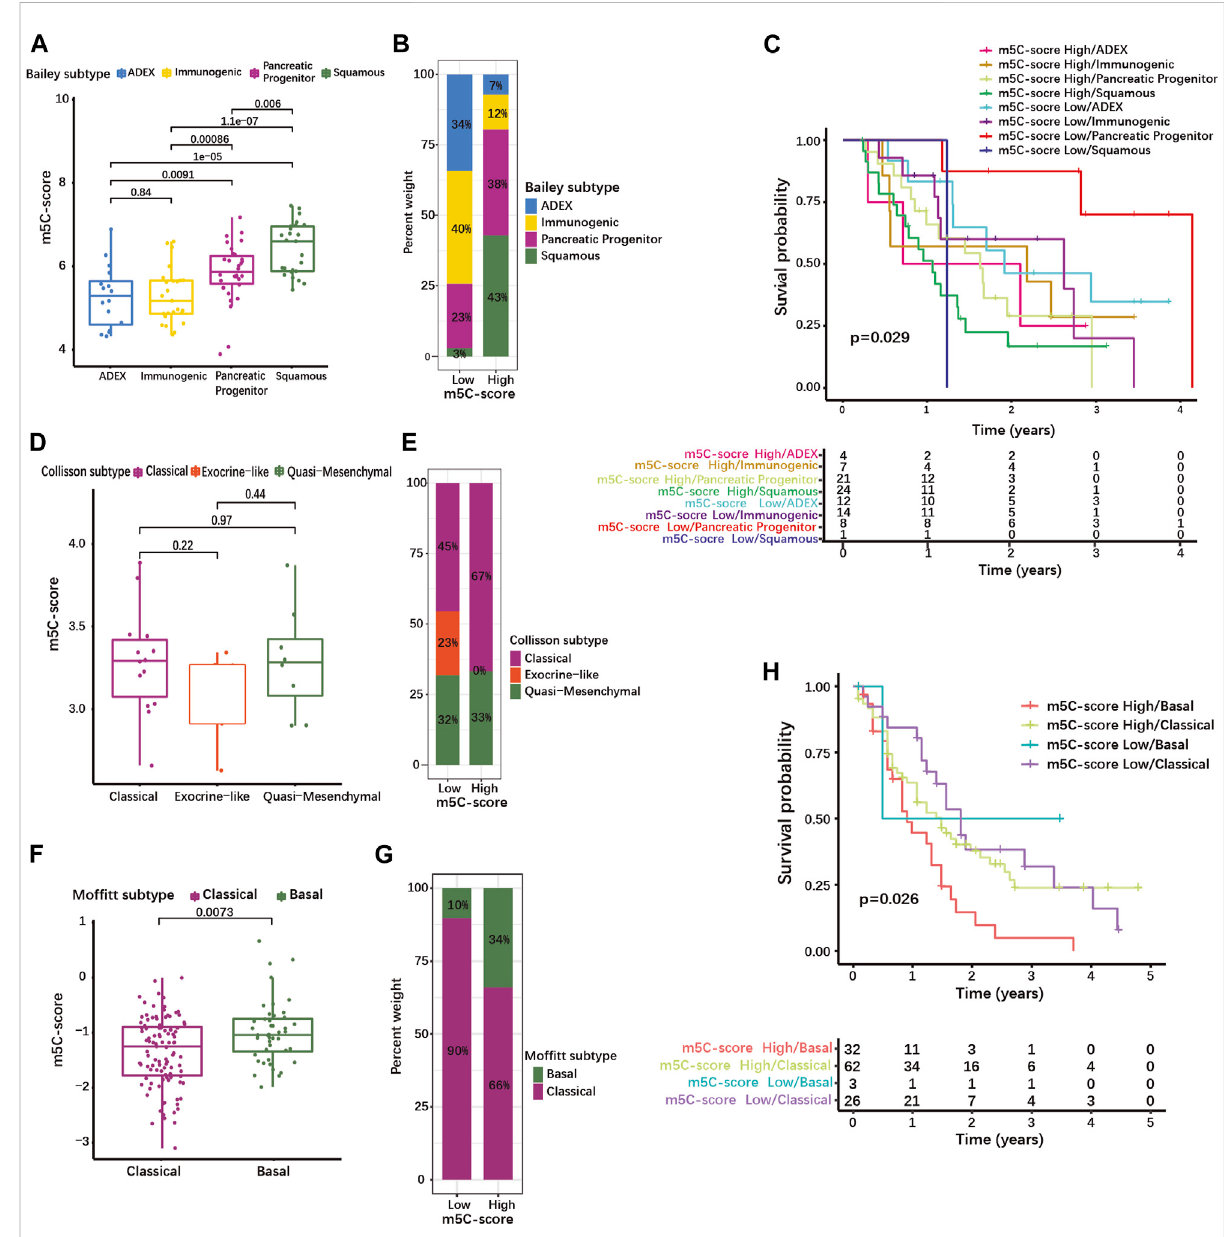
FIGURE 6 High m5C-score is associated with the squamous/basal molecular subtype and poor prognosis in PDAC. (A) m5C-score levels in the different molecular subtypes de fi ned by Bailey et al.; (B) Distribution of Bailey ’ s molecular subtypes in high- and low-m5C-score PDACs; (C) K-M curves illustrating OS according to the combination of the m5C-score with Bailey ’ s molecular subtypes analyzed by log-rank test. (D) m5C-score levels in the different molecular subtypes de fi ned by Collisson et al.; (E) Distribution of Collisson ’ s molecular subtypes in high- and low-m5C-score PDACs. (F) m5C-score levels in the two molecular subtypes de fi ned by Mof fi tt et al.; (G) Distribution of Mof fi tt ’ s molecular subtypes between high- and low-m5C-score PDACs; (H) K-M curves illustrating OS according to the combination of the m5C-score with Mof fi tt ’ s molecular subtypes analyzed by log-rank